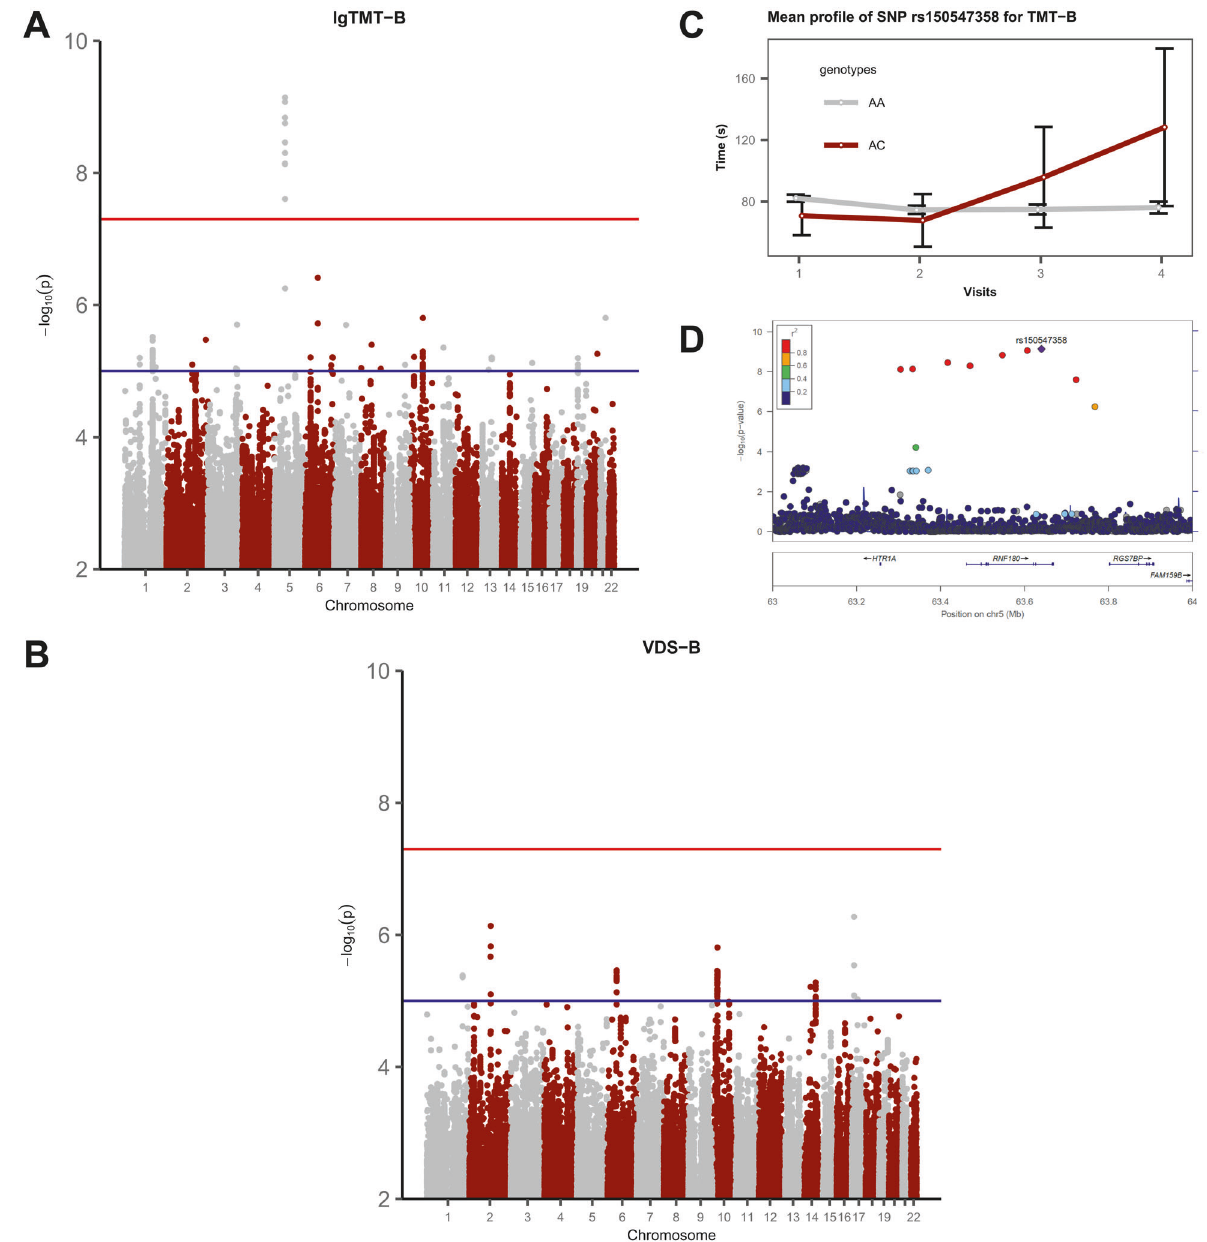
Fig. 2 Results of the genome-wide association studies of the discovery sample. A Manhattan plot of the GWAS of lgTMT-B in the discovery sample. The lines in ( A ) and ( B ) indicate the thresholds for the genome-wide signi fi cance of 5 × 10 − 8 (red) and for suggestive SNPs (blue, P ≤ 1 × 10 − 5 ). B Manhattan plot of the GWAS of VDS-B in the discovery sample. C Mean pro fi le of TMT-B by the top SNP rs150547358 genotypes for the discovery sample (1039 AA, 28 AC, 0 CC) with the 95% con fi dence intervals. D GWAS regional Manhattan plot of chromosome 5 for lgTMT-B of the discovery sample. Colors indicate the LD values ( r 2 ) of SNPs with rs150547358 (in associated with the regulation of monoamine levels in different brain regions, for example, the prefrontal cortex (PFC) in RNF180 knockout mice [51]. The PFC is a critical part of the frontal lobe in the development of EFs [4, 52]. Another gene located in the nearby region, HTR1A (5-hydroxytryptamine receptor 1A), is an important receptor of serotonin (5-HT) also essential to the prefrontal lobe. More importantly, HTR1A is an autoreceptor, located on the cell bodies of serotonin-synthesizing neurons of the brainstem dorsal raphe nucleus, helping to maintain home- ostasis in serotonergic function [53]. Furthermore, a genetic polymorphism in the 5-HT system has previously been implicated in EF performance [12].